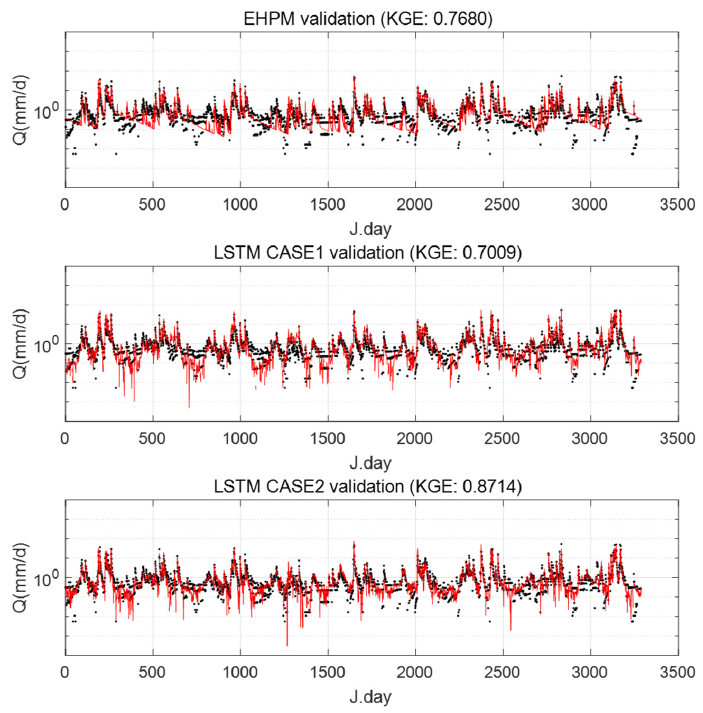
Figure 7. Observed and predicted streamflow time series in Basin 4 for each case. The black dots are the observed streamflow and red solid lines are the streamflow predicted by each case.